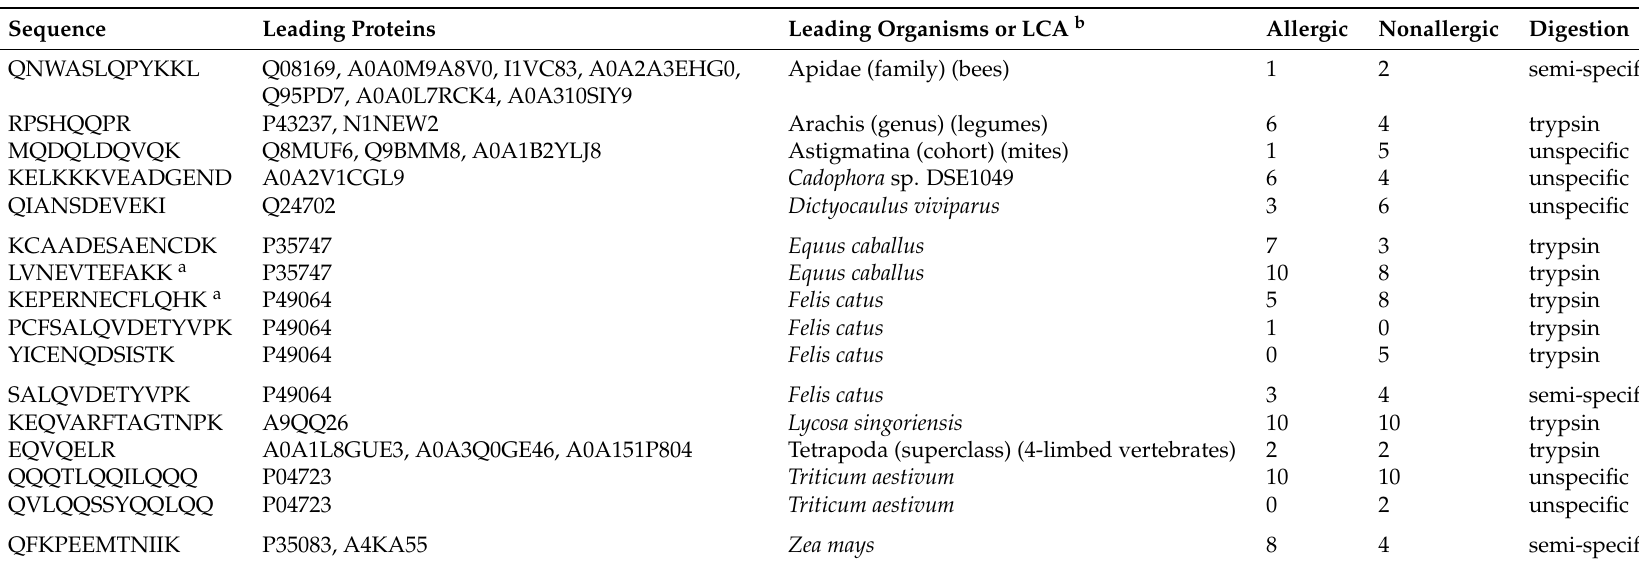
Table 3. All identified nonhuman peptide sequences that were assigned to non-bovine allergens with the corresponding UniProt protein id, leading organism, and in silico digestion mode. Per group of allergic and nonallergic mothers, the number of samples in which the peptide sequence was identified is